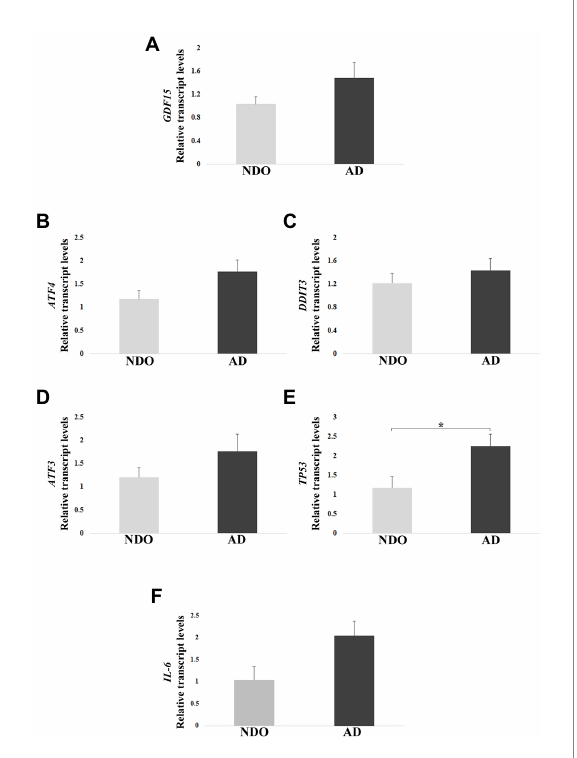
FIGURE 2 Real-Time RT-PCR analysis in AD patients (AD) and age-matched non-demented old controls (NDO). (A) GDF15, (B) ATF4, (C) DDIT3, (D) ATF3, (E) TP53, and (F) IL-6 relative transcript levels in frontal cortex samples from 10 AD and 5 NDO. The bars represent mean ± SE. Student’s t test was applied. * p < 0.05.